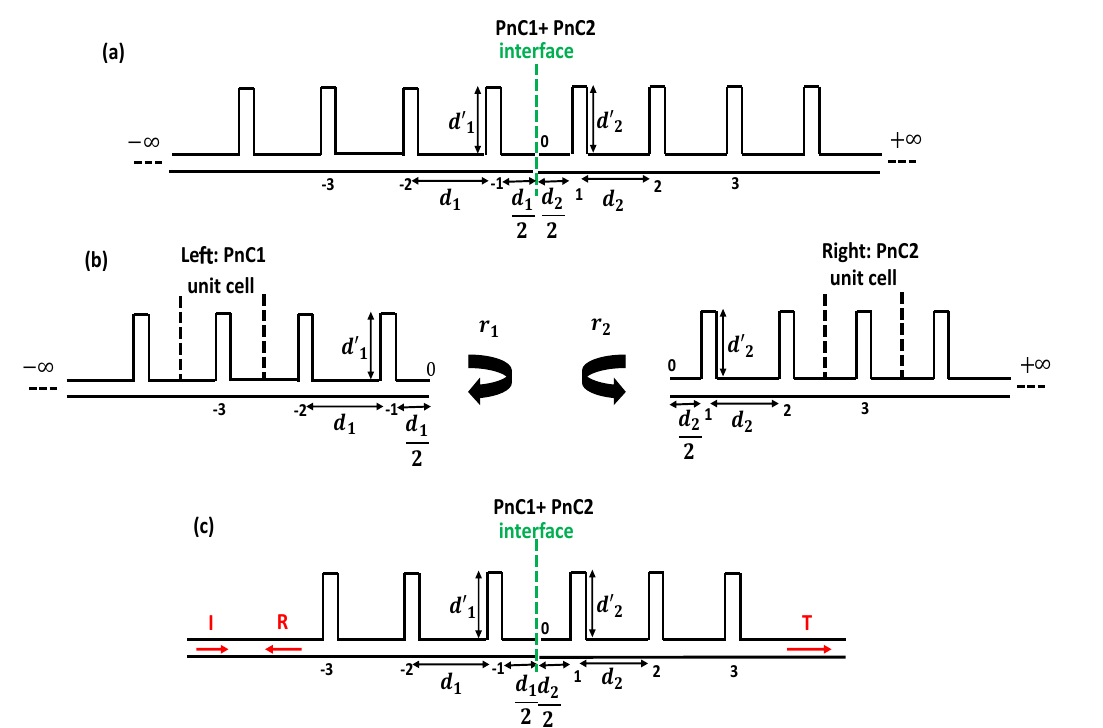
Figure 1. ( a ) Interface between two semi-infinite PnCs terminated by segments of lengths d 1 Each PnC is composed of one stub by period. ( b ) Semi-infinite PnCs (the first PnC in the left and the second one in the right) in contact with a waveguide. r 1 and r 2 are the reflection coefficients for the PnC1 and PnC2, respectively. ( c ) Interface between two finite PnCs each one composed of 3 cells. I, R and T denote the incident, reflected and transmitted acoustic waves,